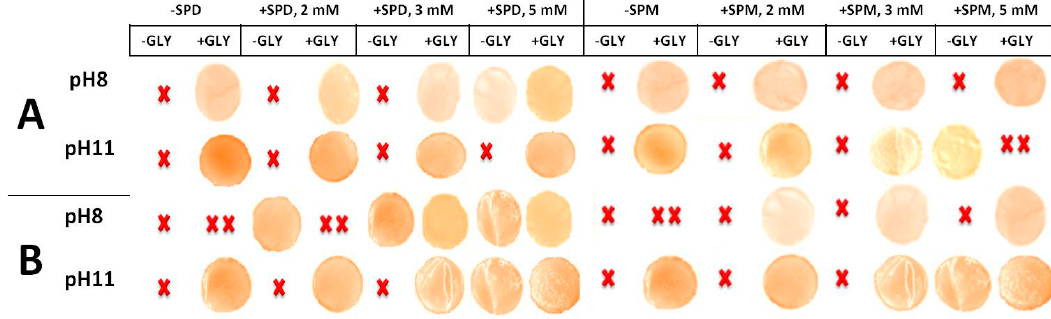
Figure 5. Films obtained by casting 25 °C-treated ( A ) and 80 °C-treated ( B ) BVPC FFSs previously incubated at either pH 8.0 or 11.0 in the presence of different concentrations of either SPD or SPM and/or 42 mM GLY. Brittle (X), sticky (XX) or handleable (photos) films are indicated. Further experimental details are given in the text.